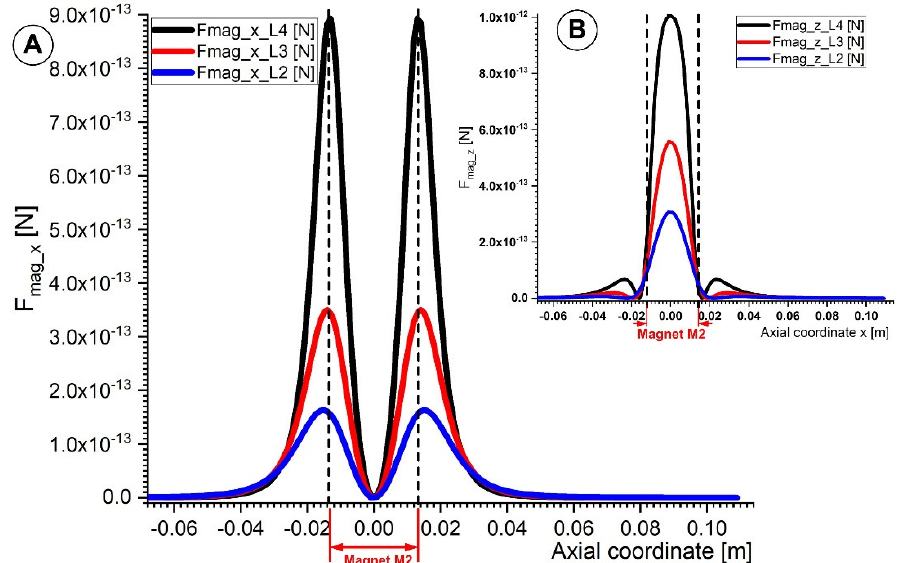
Figure 11. Comparison of the magnetic force components for magnet M2 along the vessel axial coordinate. ( A ) Evolution of magnetic force x and z components at various distances from the magnet surface (lines L4, L3, and L2 in Figure 8). ( B ) A comparison of the vertical magnetic force component F mag_z along the lines L4, L3, and L2.